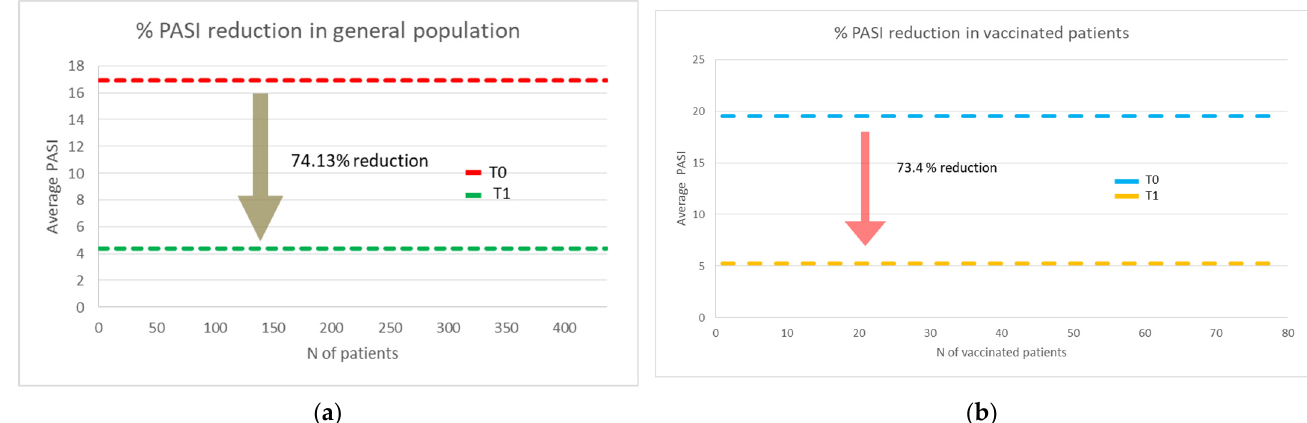
Figure 1. Average PASI at baseline and after 24 weeks in ( a ) all the vaccinated and non-vaccinated subjects, and ( b ) in vaccinated subjects.